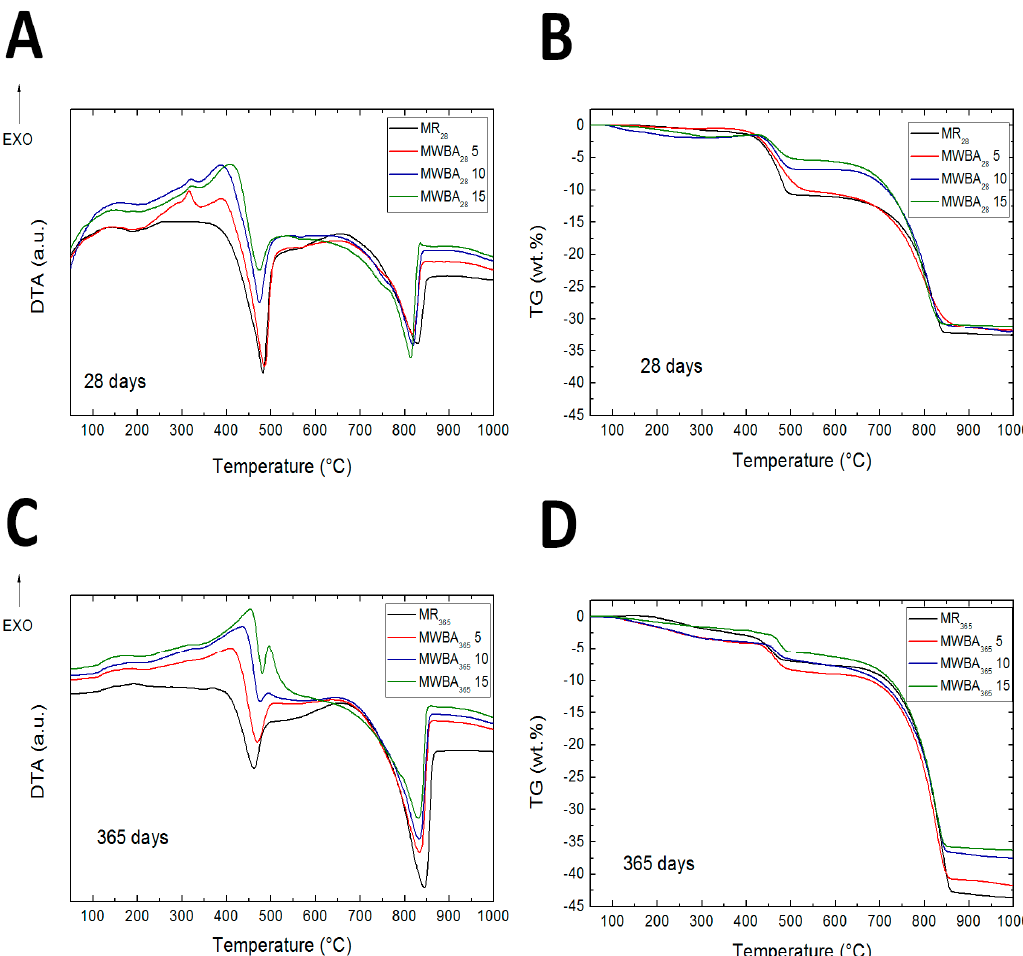
Figure 6. Pore size distribution of tested mortars: 365 day samples.